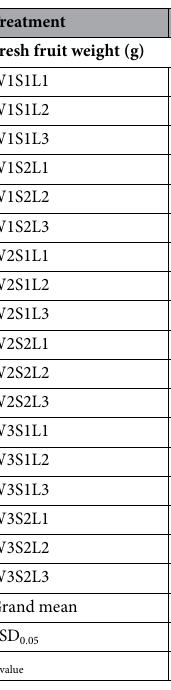
Table 3. Treatment interaction effect on the fresh fruit weight (g) of African horned cucumber. Treatment interaction effect on the fruit weight of African horned cucumber. W1 no water stress, W2 moderate water stress, W3 severe water stress, S1 loamy soil and S2 sandy loam, L1 means greenhouse, L2 means shade net, L3 mean open field, WUE water use efficiency. Numbers in brackets represent the standard deviations of the mean. LSD 0.05 is the least significant difference of means. Years (seasons one—2017/18 and season two— 2018/2019). P values in bold are lower than